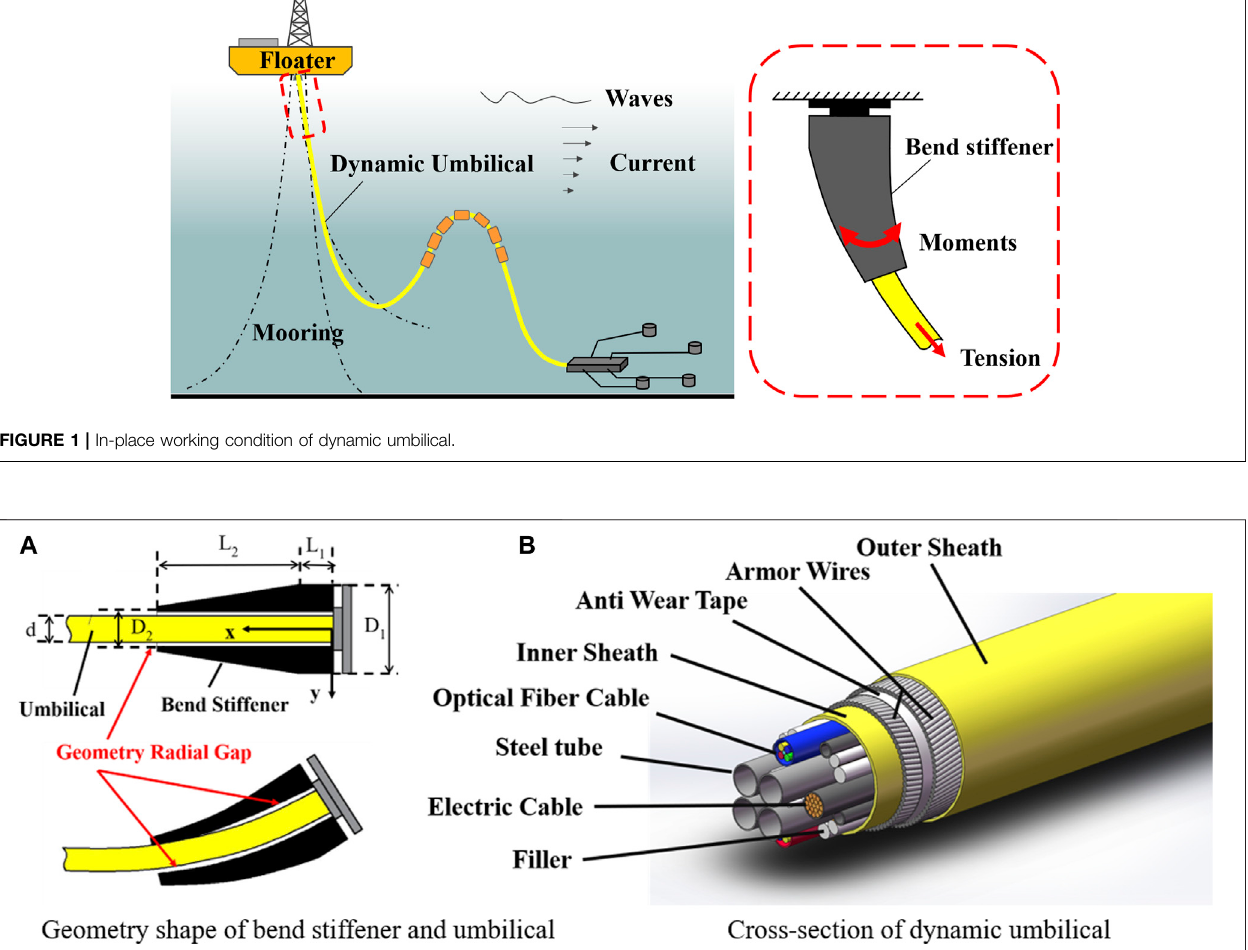
FIGURE 2 | Shape of bend stiffener and Cross-section of the